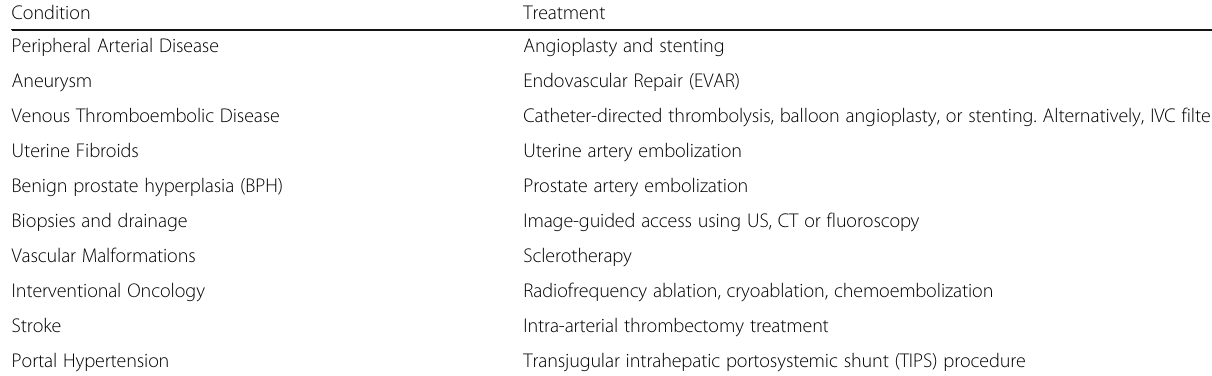
Table 1 Principle IR subjects, presently Condition Peripheral Arterial